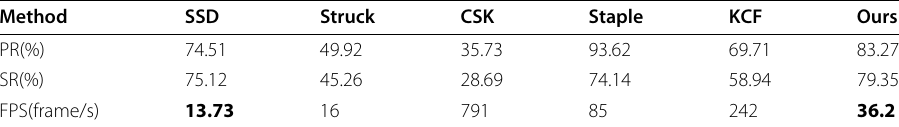
Table 1 The contrast of tracking accuracy and speed result